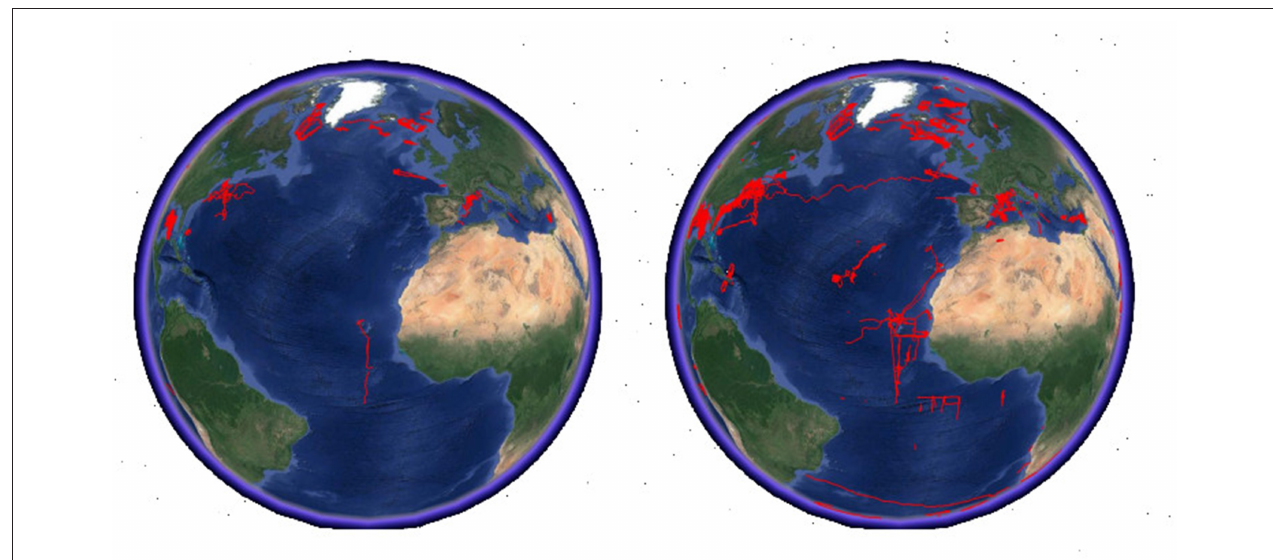
FIGURE 1 | Development of the glider activity over the past decade. Gliders tracks of past deployments (left) until December 2009 (OceanObs’09) and (right) until October 2018 (OceanObs’19 submissions), as can be viewed using